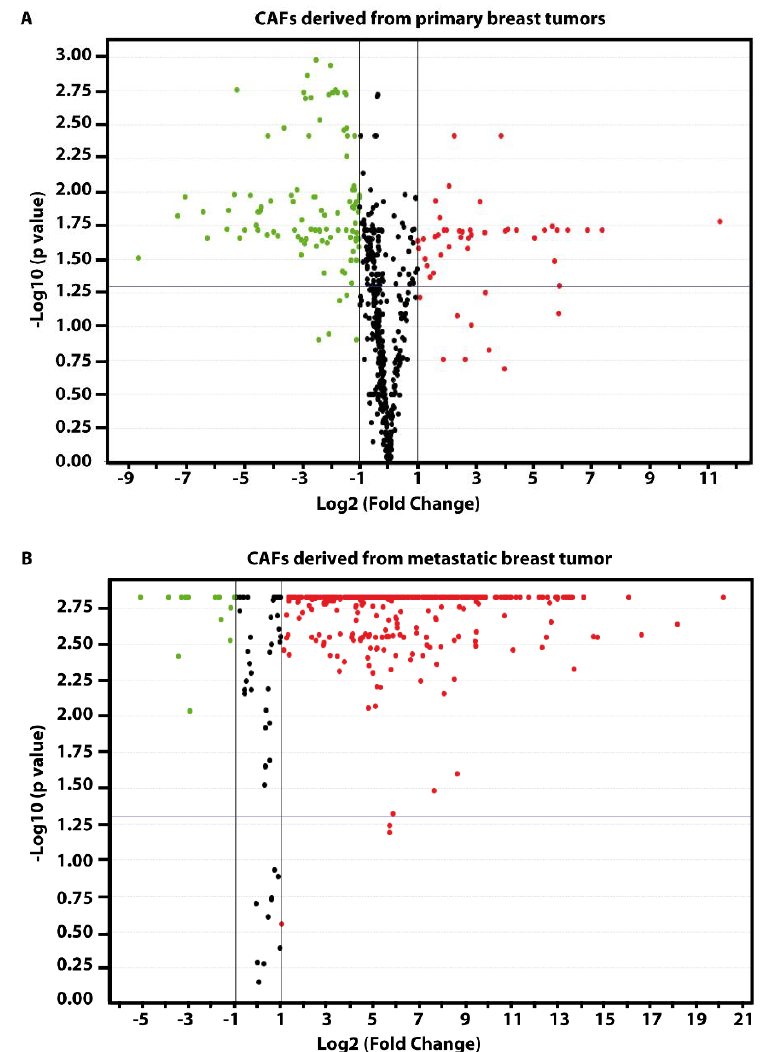
Figure 1. Volcano plot of miRNAs in cancer associated fibroblasts (CAFs) derived from primary breast tumors ( A ) and metastatic breast cancer ( B ) upon treatment with 100 nM E2 (17β -estradiol) for 4 h. The x -axis represents log2 Fold Change of miRNAs expression in estrogen stimulated samples versus vehicle treated samples, the y -axis represents – log10 p -values. The vertical dashed lines represent Fold Change = 2.0, while the horizontal dashed line represents p -value = 0.05. Points to the left (green) and right (red) of the plots represent miRNAs significantly downregulated and upregulated by E2 treatment, respectively.